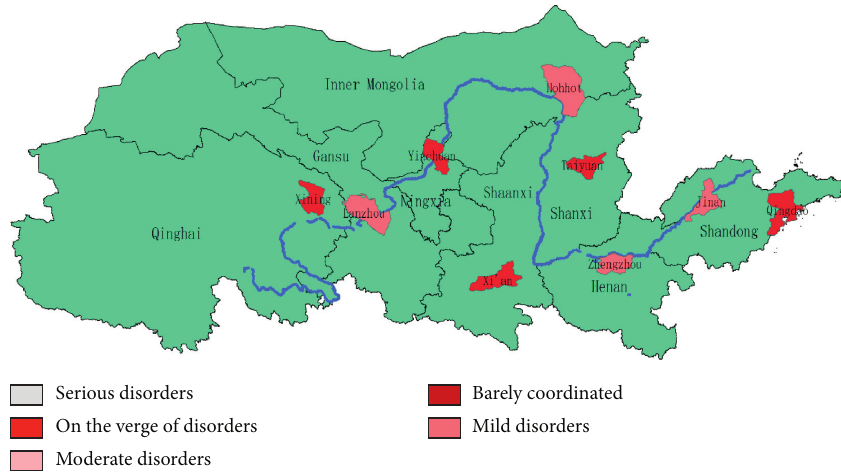
Figure 6: Coupling coordination level of central cities in the Yellow River Basin in 2012.